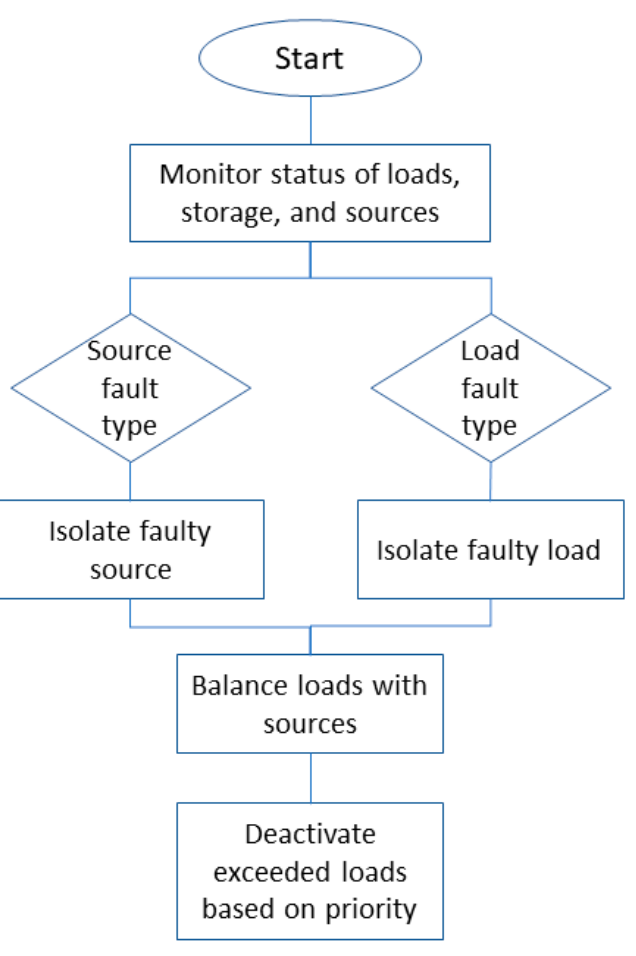
Figure 5. Fault tolerance algorithm based on PLC and relay